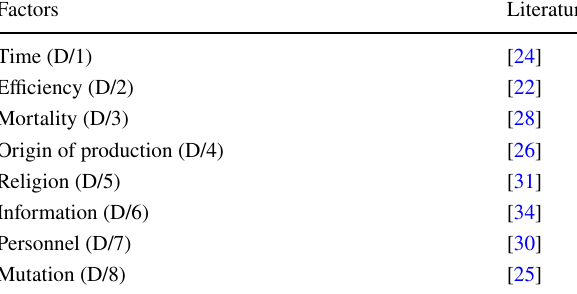
Table 1 The criteria of vaccine hesitancy in the COVID-19 period Factors Literature